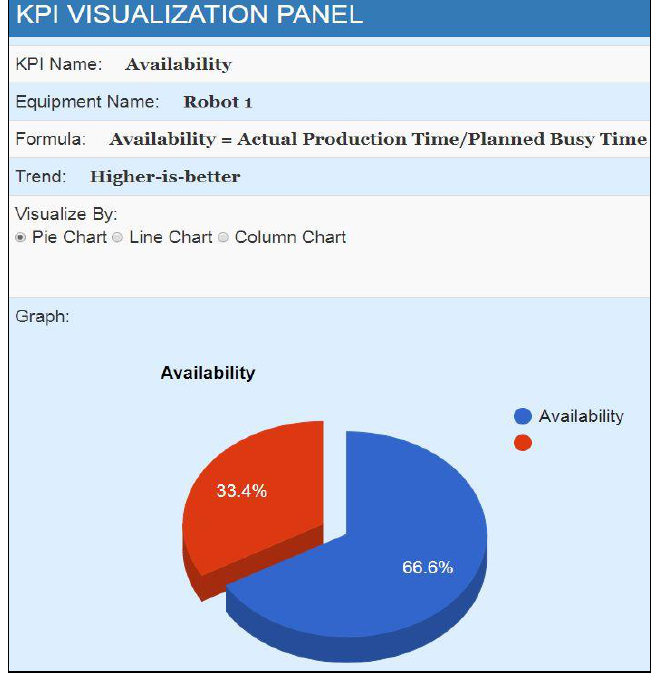
Figure 11 . Availability KPI of Robot 1. Figure 11. Availability KPI of Robot